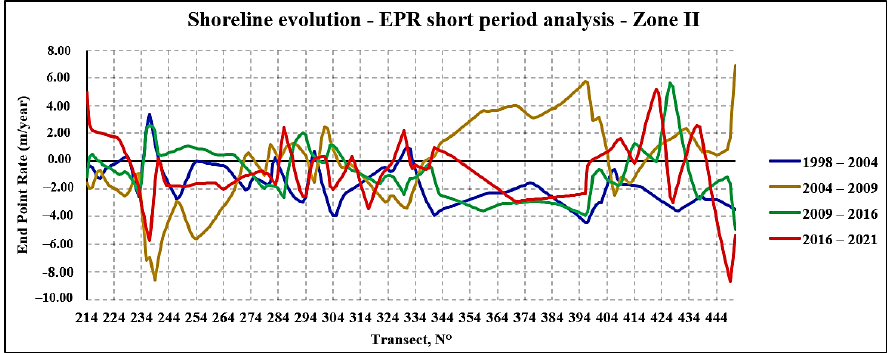
The average value of erosion recorded for the years 2004–2009 is the second highest